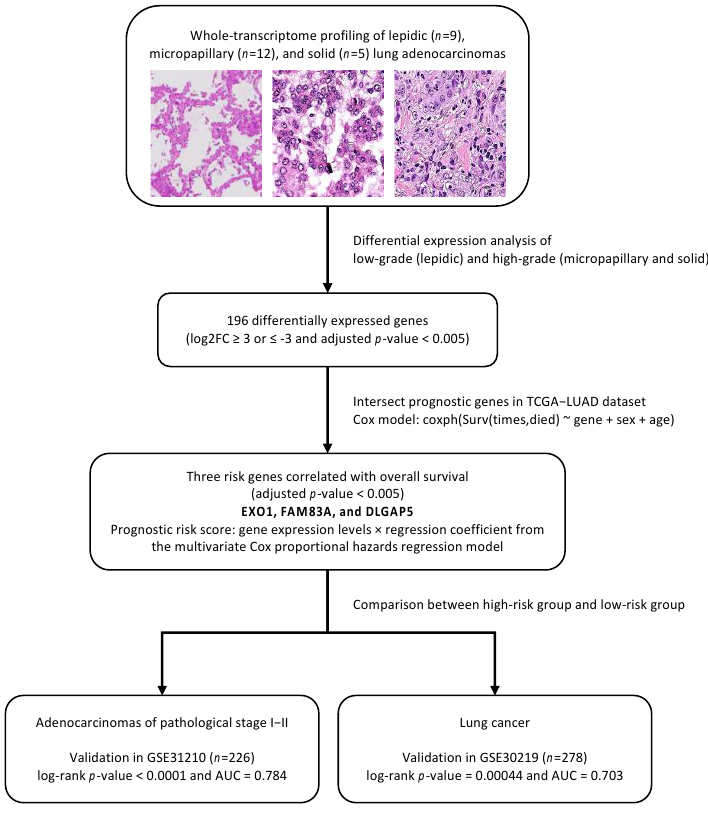
Figure 1. Flowchart of a three-gene prognostic signature construction and validation.